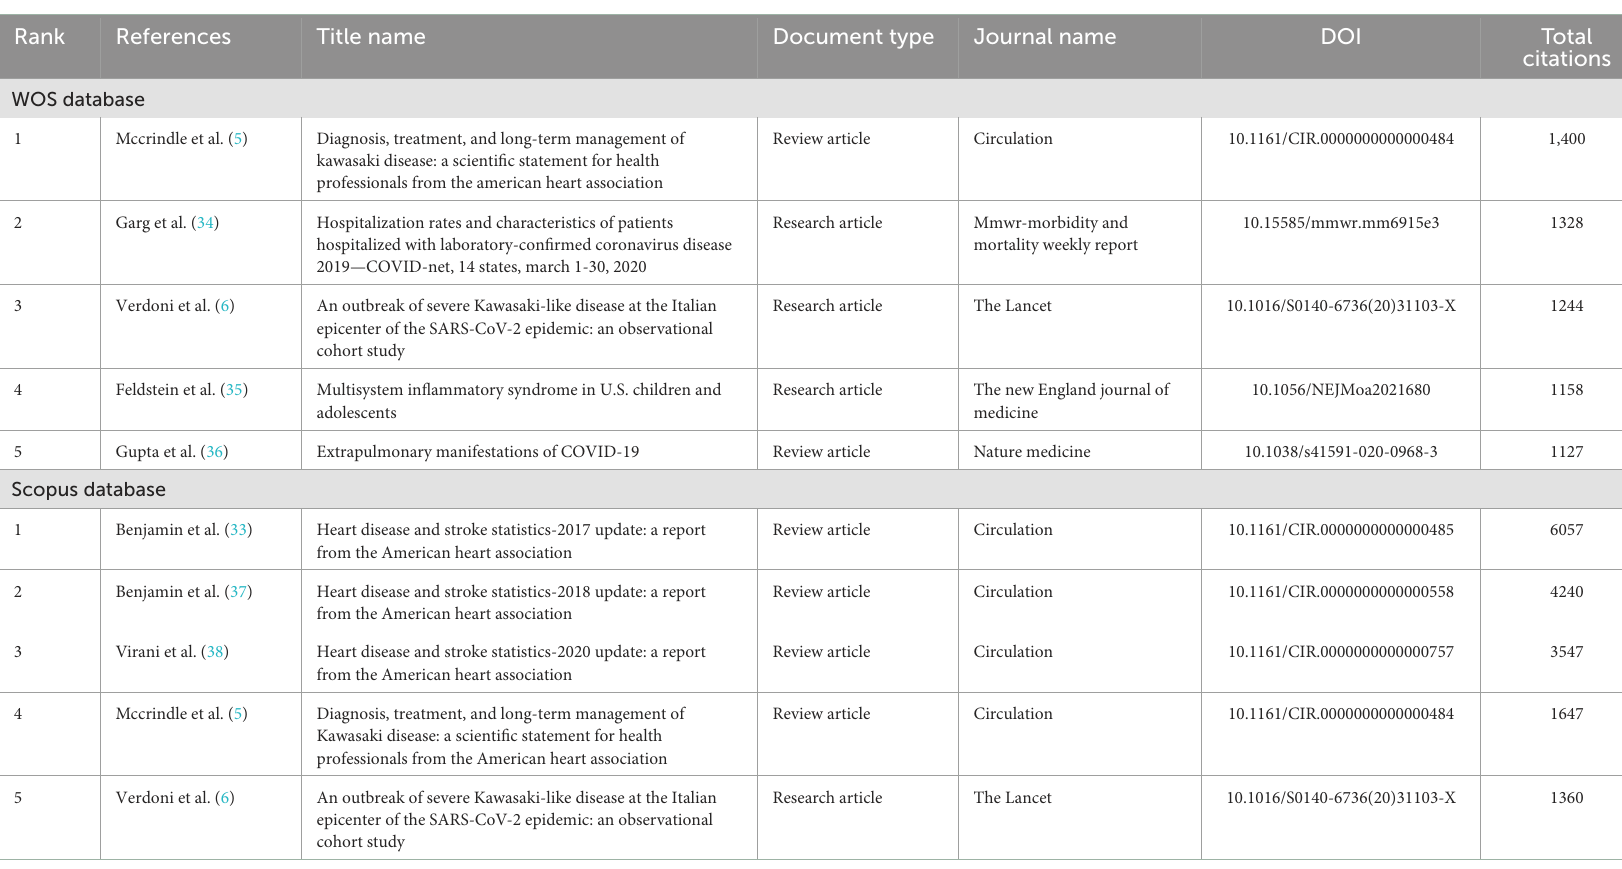
TABLE 5 The top 5 most cited documents on KD